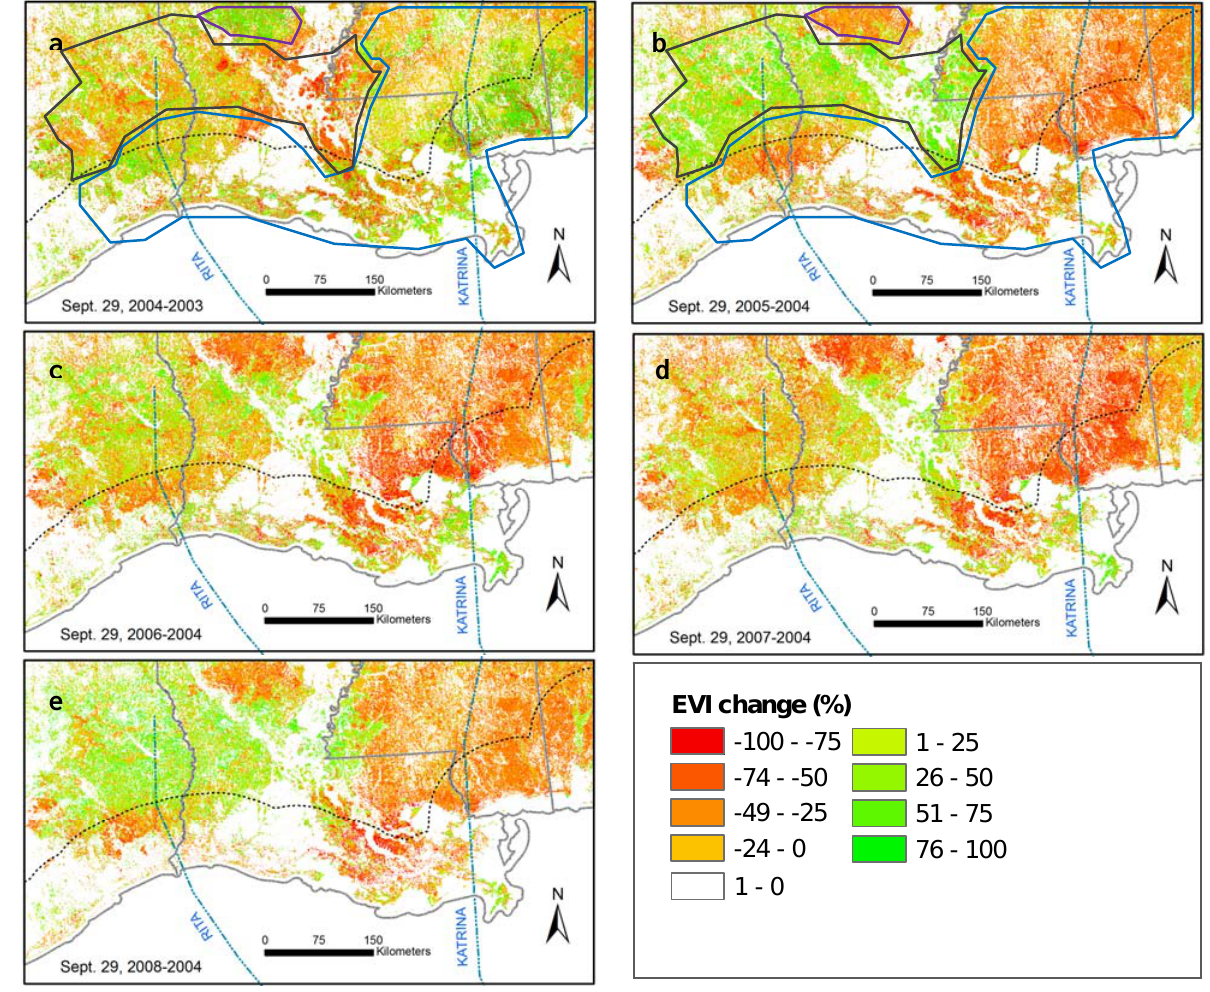
Figure 7. (a) Percentage changes of MODIS EVI products between 2004–2003, and (b–e) changes during 2005-2008 as compared to 2004. The changes presented in (a) were used as a reference to identify Hurricanes Katrina and Rita disturbance on images b to